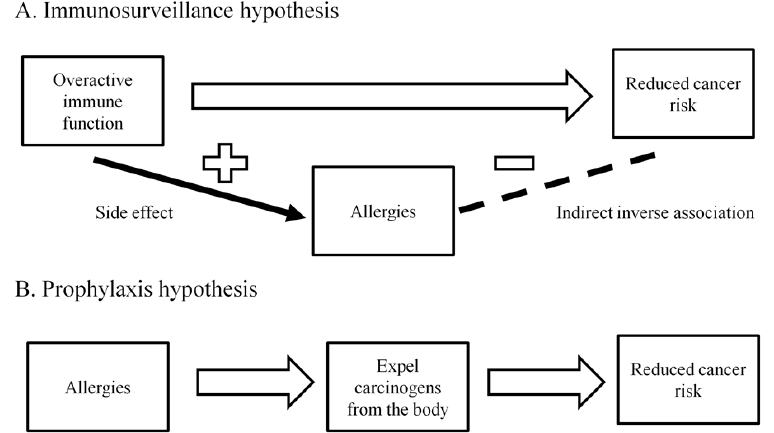
Figure 3. A. Immunosurveillance hypothesis: Allergy does not play a direct role in preventing the occurrence of cancer, but is merely a manifestation of an overactive immune function that has a high e ffi ciency of surveying and eradicating cancer cells. B. Prophylaxis hypothesis: Allergic reactions are the body’s method of expelling the